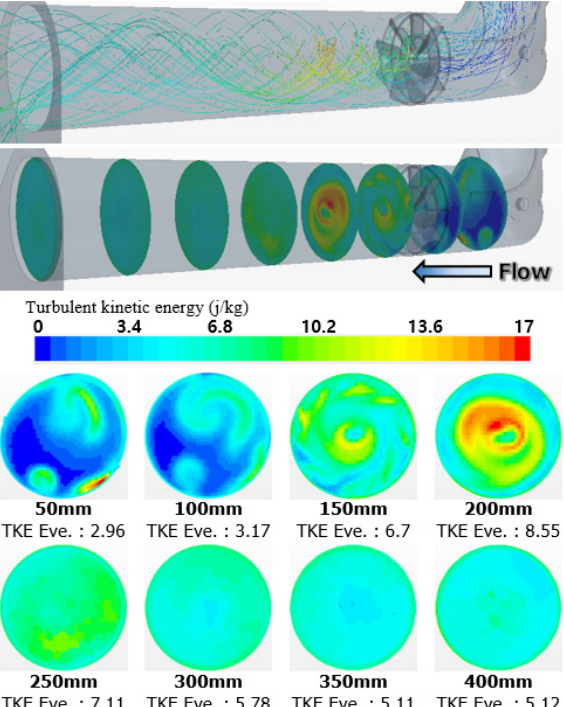
Figure 9. Development of turbulence after a urea injection point and the kinetic energies at specific distances: from 50 mm to 400 mm with 50 mm intervals.